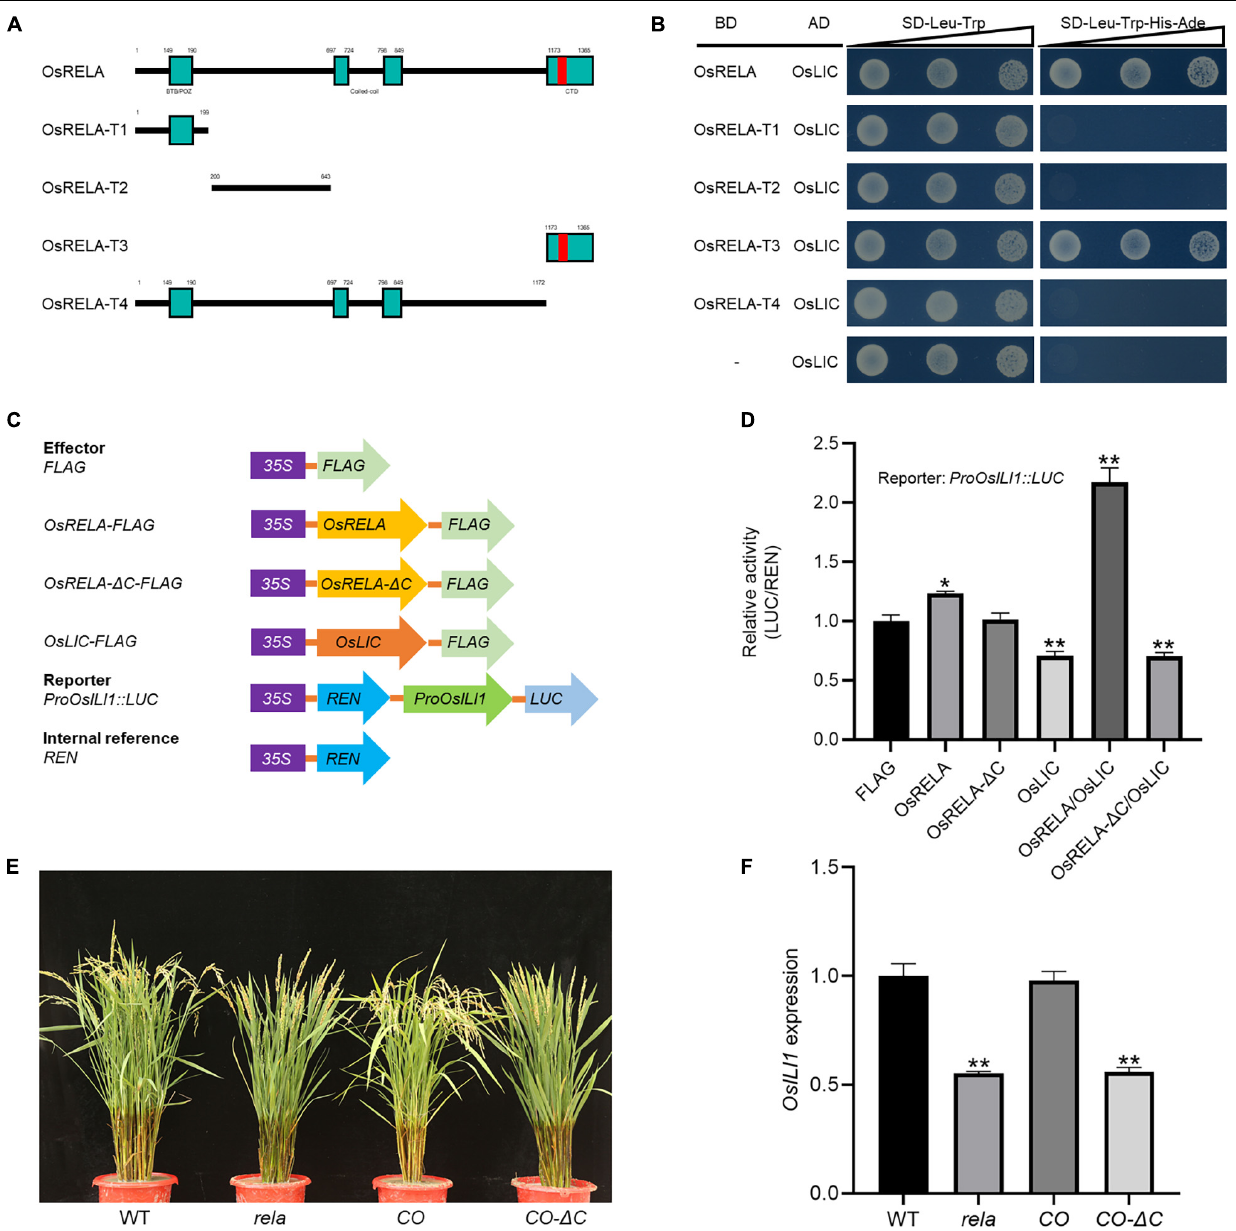
should verify whether these three genes are involved in the similar